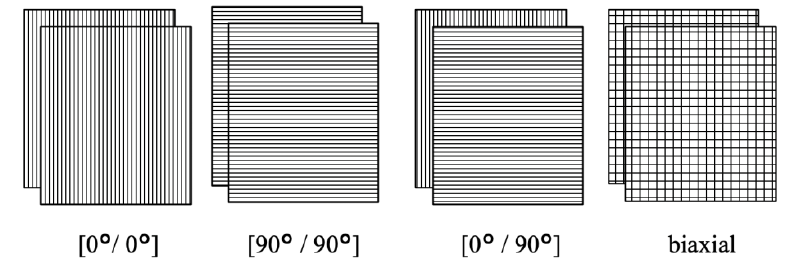
Figure 1. Schemes of the CF layout patterns (the polymer powder located between them).